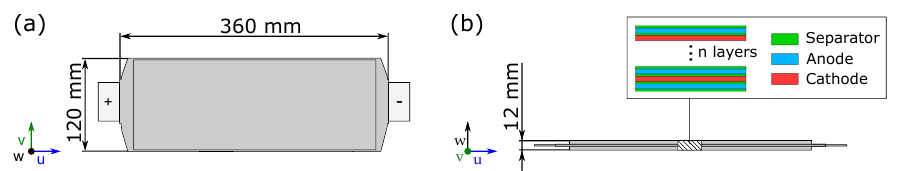
Figure 1. Structure and cell dimensions of the investigated lithium-ion pouch cell referring to Sprenger et al. [27]: ( a ) Shows the cell’s length and width. ( b ) Shows the cell’s thickness and layer